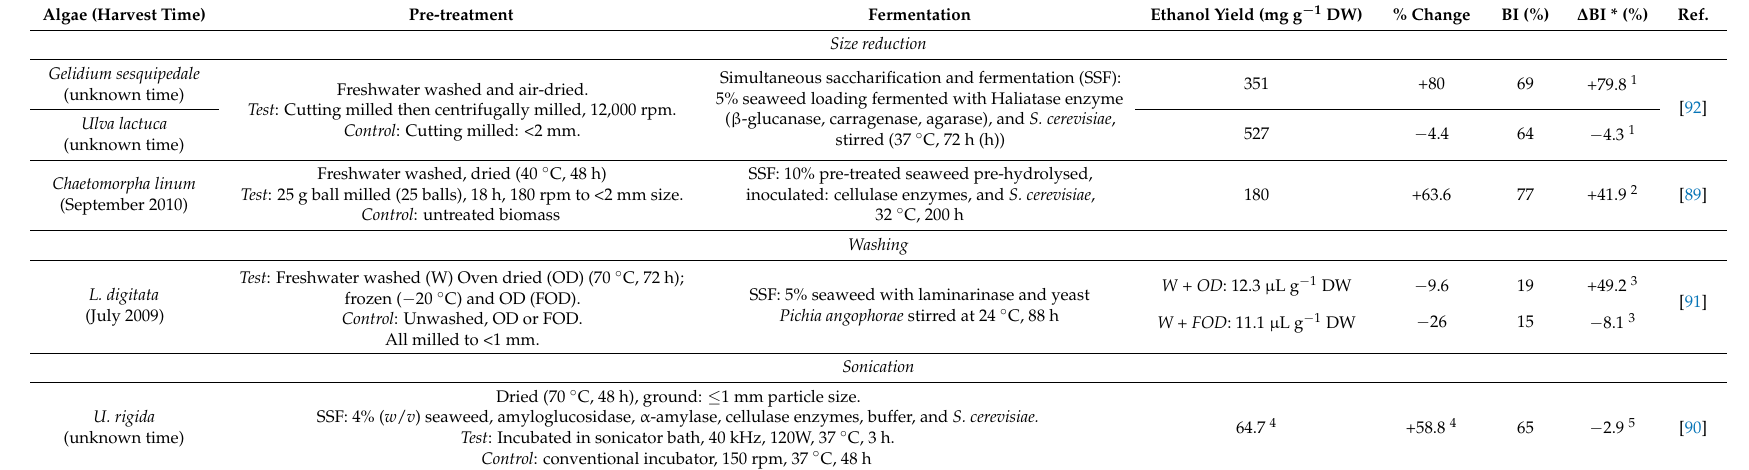
Table 2. Ethanol yield following mechanical pre-treatment of seaweed.